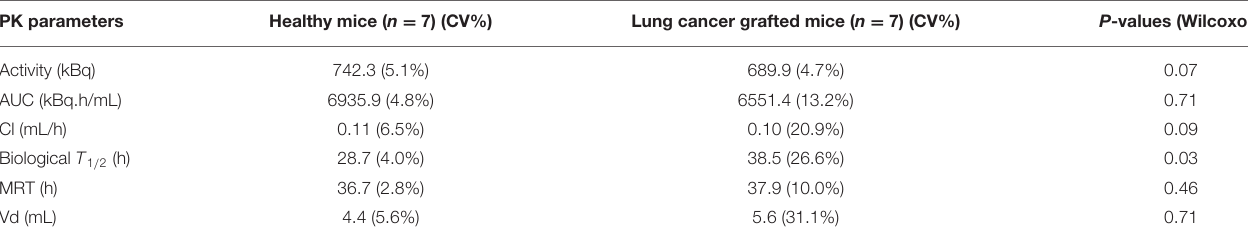
AUC, the area under the curve; Cl, clearance; T 1 / 2 , half-life time; MRT, mean residence time; Vd, volume of distribution; CV(%), coefficient of variation; PK, pharmacokinetics.